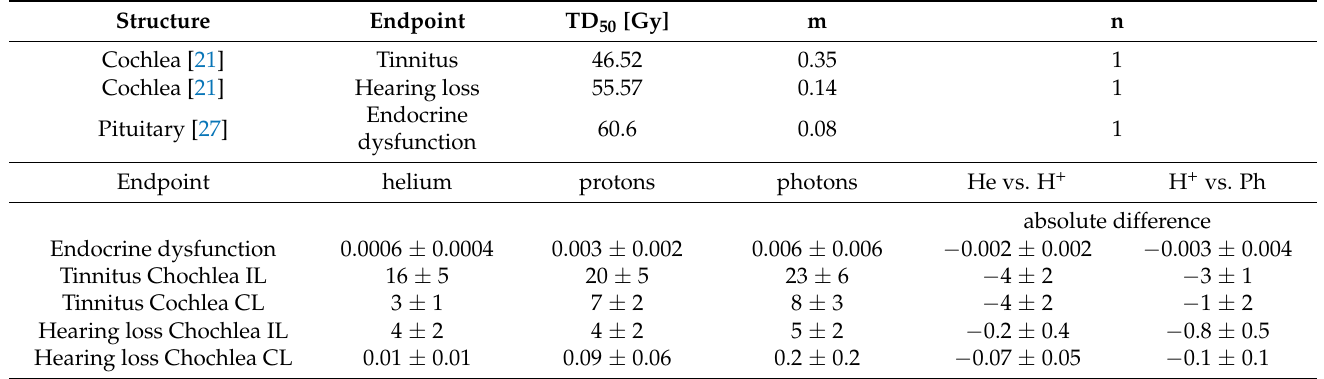
Table 1. NTCP parameters and comparison of NTCP.